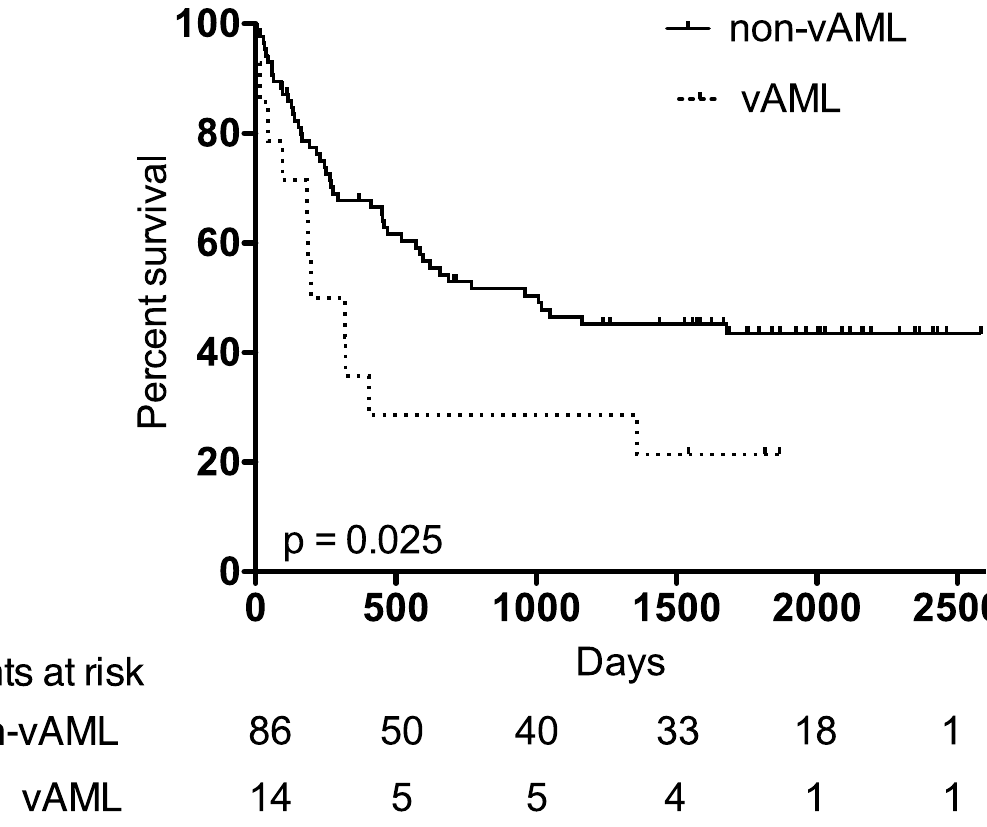
Fig 2. Kaplan-Meier curves for overall survival (OS). Dotted line indicates OS of AML patients with blast vacuolization (vAML) and solid line indicates OS of AML patients without evidence of blast vacuolization